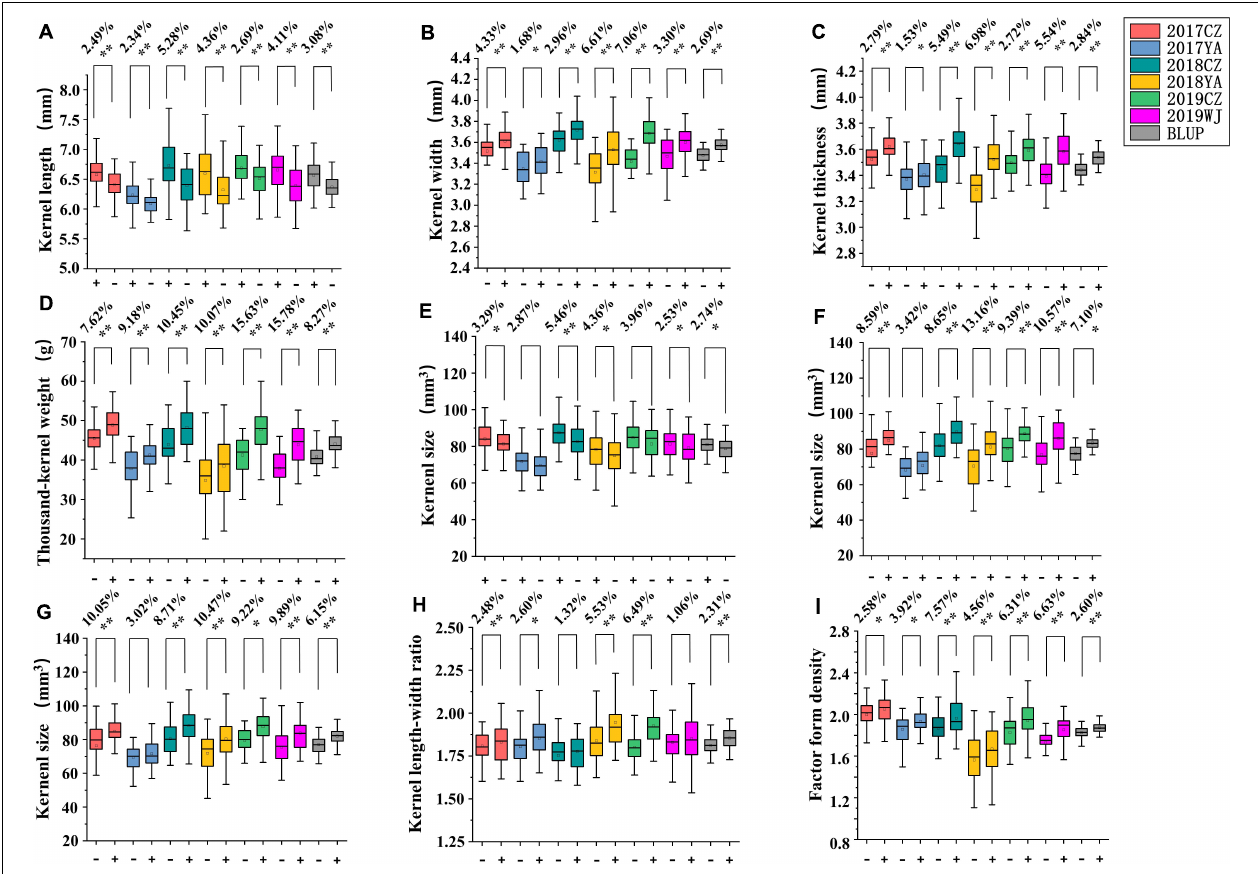
FIGURE 4 | Genetic effects of QKL.sicau-2SY-1B (A) , QKW.sicau-2SY-6D (B) , QKT.sicau-2SY-2D (C) , QTKW.sicau-2SY-2D (D) , QKS.sicau-2SY-1B (E) , QKS.sicau-2SY-2D (F) , QKS.sicau-2SY-6D (G) , QLWR.sicau-2SY-6D (H) , and QFFD.sicau-2SY-2D (I) in 2SY population. Different colors represent different environments and BLUP. In (A,E) “+” and “-” represent homozygous lines carrying “SY95-71” and “20828” alleles, respectively; In (B–I) “+” and “-” represent homozygous lines carrying “20828” and “SY95-71” alleles, respectively. **Significance at the 0.01 probability level; *significance at the 0.05 probability